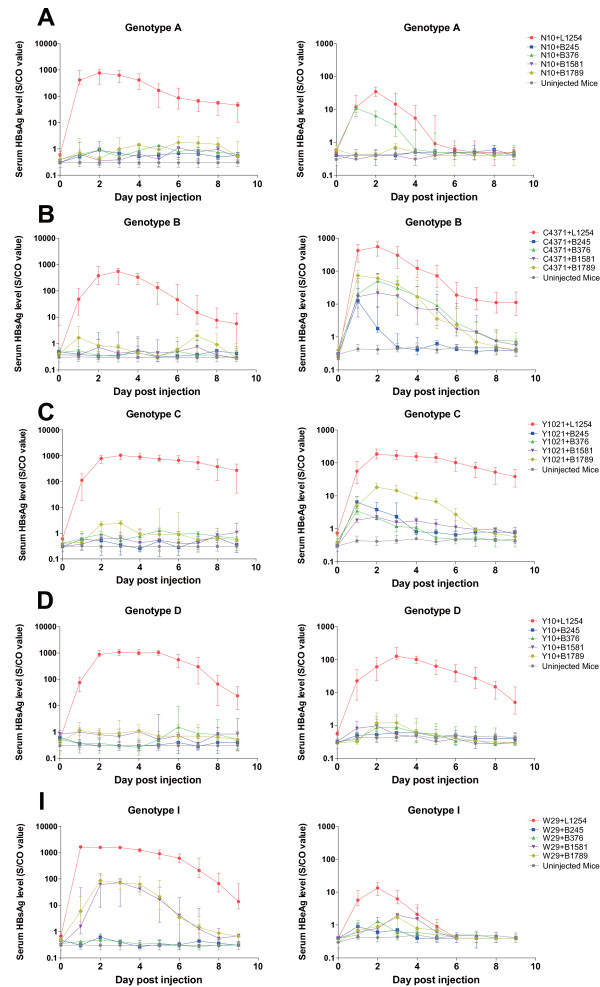
Kinetics of serum HBV antigen (HBsAg and HBeAg) of various HBV genotypes in RNAi-treated mice. For each group (each line in the figure), the experiment was repeated using two different groups of five mice. Due to limited serum resources, each sample was diluted 10-fold. (A) Genotype Ae (N10 group), (B) Genotype Ba (C4371 group), (C) Genotype C1 (Y1021 group), (D) Genotype D1 (Y10 group), (E) Genotype I1 (W29 group).